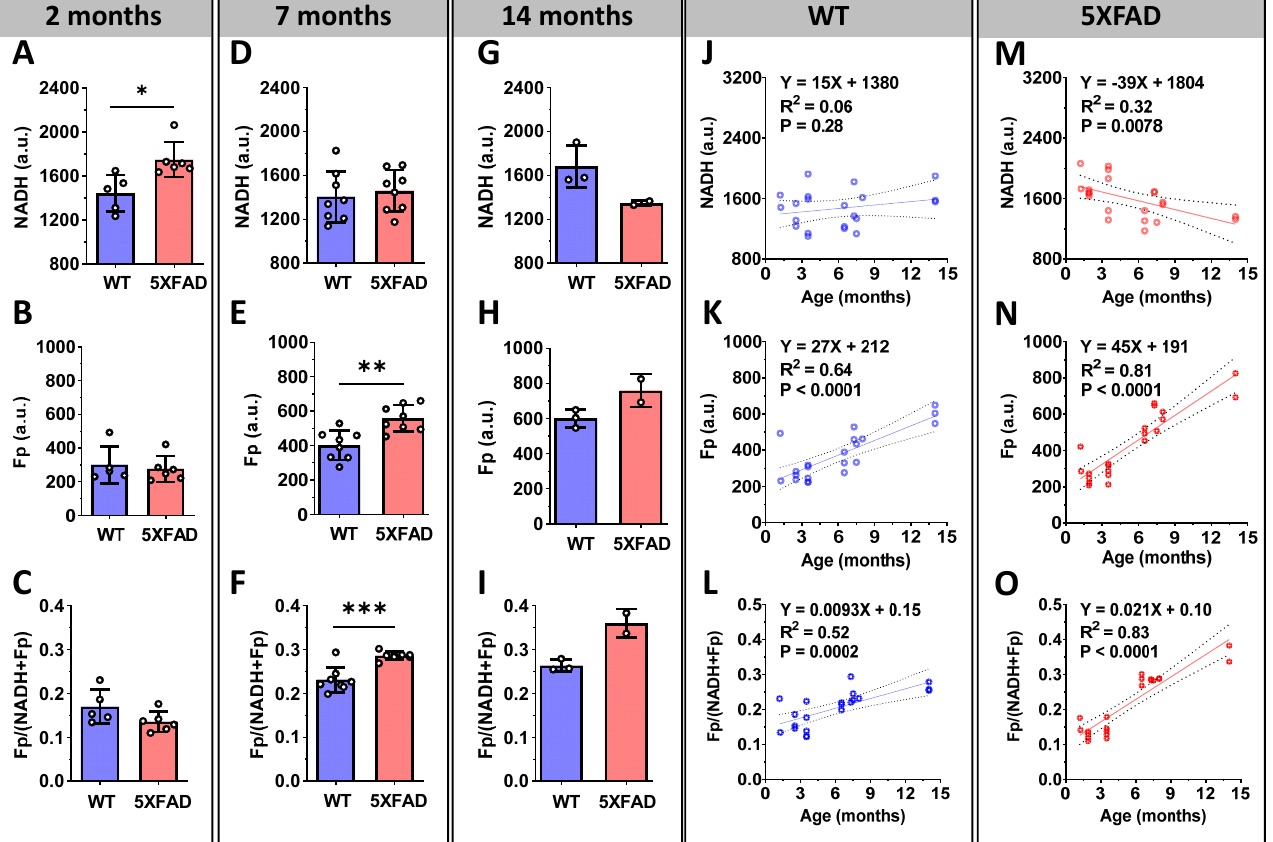
Figure 4. The relationship between redox indices and age in the hippocampi of 5XFAD and wild type mice. Quantified hippocampal redox indices in 2 month ( A – C ), 7 month ( D – F ), and 14 month ( G – I ) groups are graphed with mean ± SD (*, p < 0.05; **, p < 0.01; ***, p < 0.001) and individual mouse values (dots). Linear regressions were performed to represent the trend of time courses of the redox indices (each dot represents the hippocampus from an individual mouse) for WT ( J – L ) and 5XFAD ( M – O